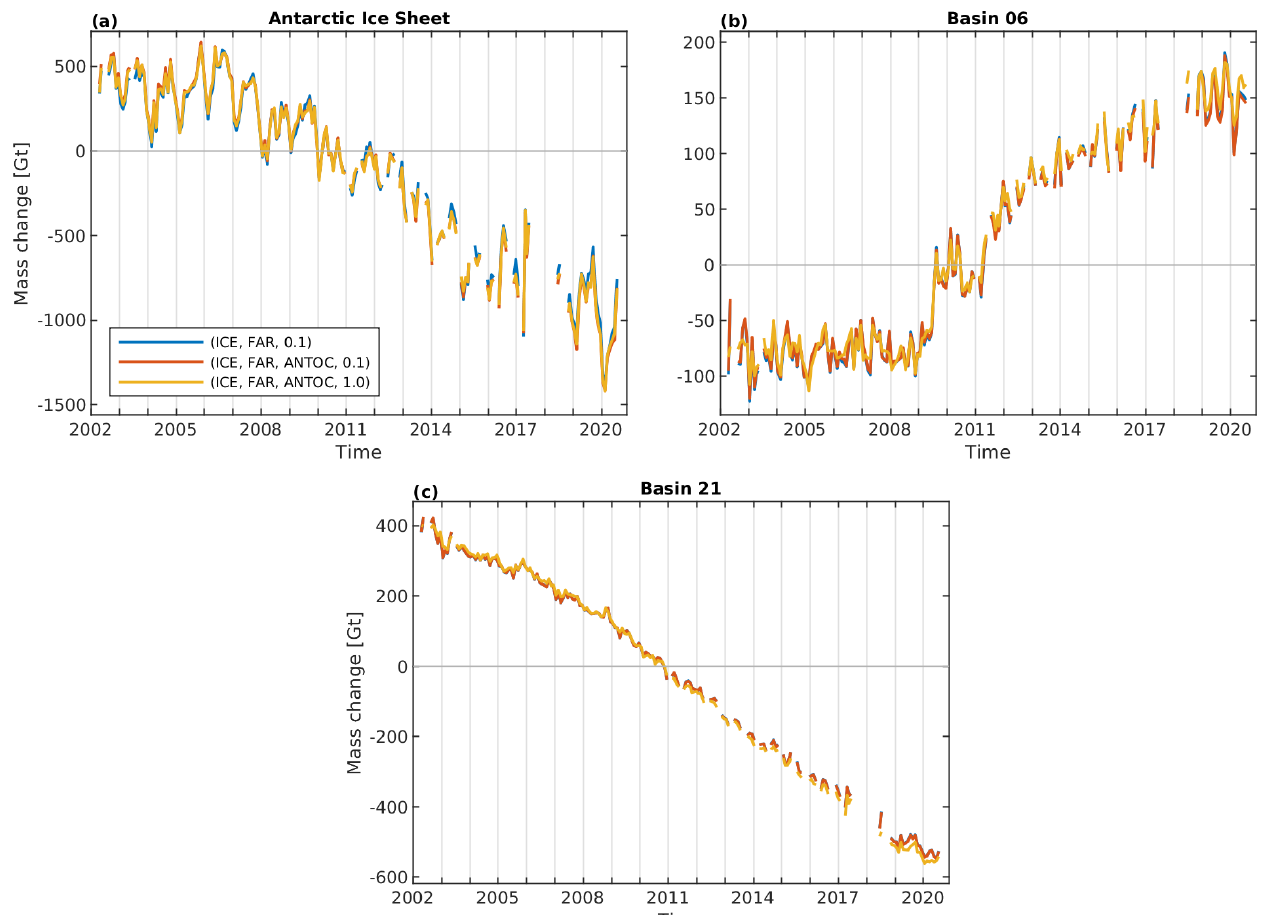
Figure 3. Mass change time series, i.e., the gravimetric basin product, for ( a ) the entire Antarctic Ice Sheet, ( b ) Basin 06 and ( c ) Basin 21 derived using different realizations of tailored sensitivity kernels.